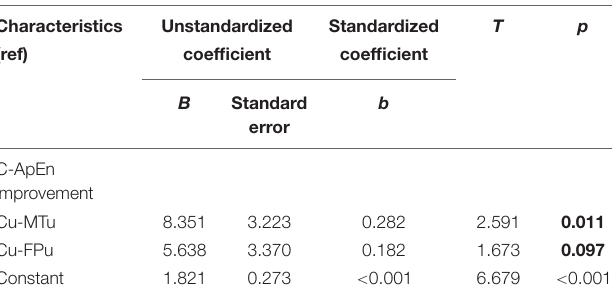
TABLE 7 | The relevant factors for CRS-R improvement based on multivariate linear regression analysis (under the unaffected painful stimulus condition).